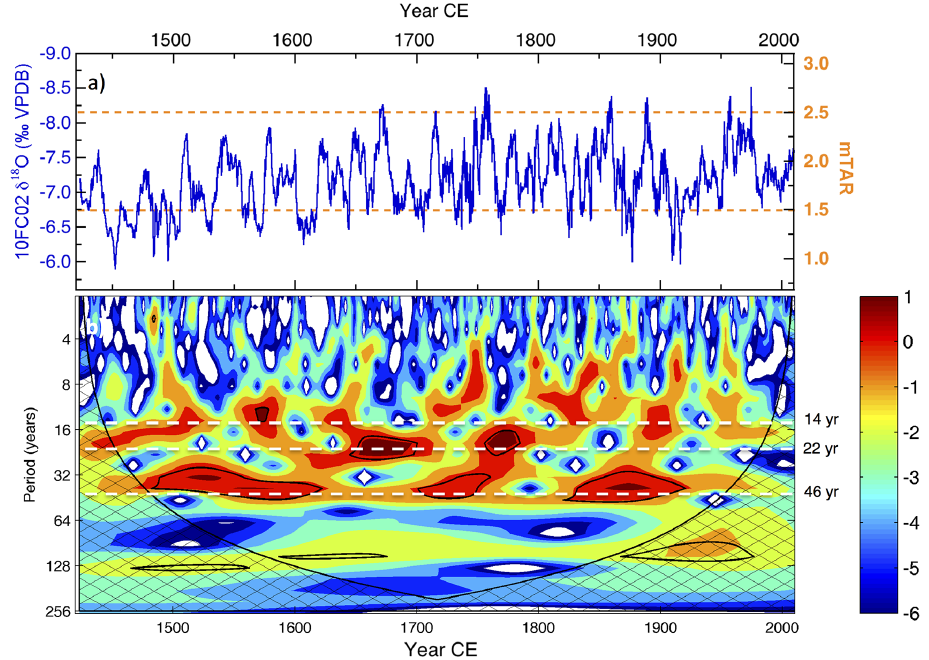
Figure 8. (a) Variations in stalagmite δ 18 O (left axis) and calculated rainfall (mTAR; right axis) as derived from the relationship in Fig. 6. Horizontal dashed orange lines highlight a change of 1mTAR that approximates the average range of multidecadal rainfall variability in the record. (b) Wavelet spectrum of stalagmite δ 18 O time series (Liu et al., 2007; Torrence and Compo, 1998). Black contours denote power above the 95% confidence interval when using an AR(1) red noise model; crosshatching represents the “cone of influence” (Torrence and Compo, 1998). The horizontal dashed white lines denote the period of the first 3 principal components (PCs) of the stalagmite record as calculated using singular spectral analysis and 10 components with a window length of 50. The first PC is centered at 46 years and explains 44% of the variance; the second PC is centered at 22 years and explains 23% of the variance; while the third PC is centered at 14 years and explains 13% of the